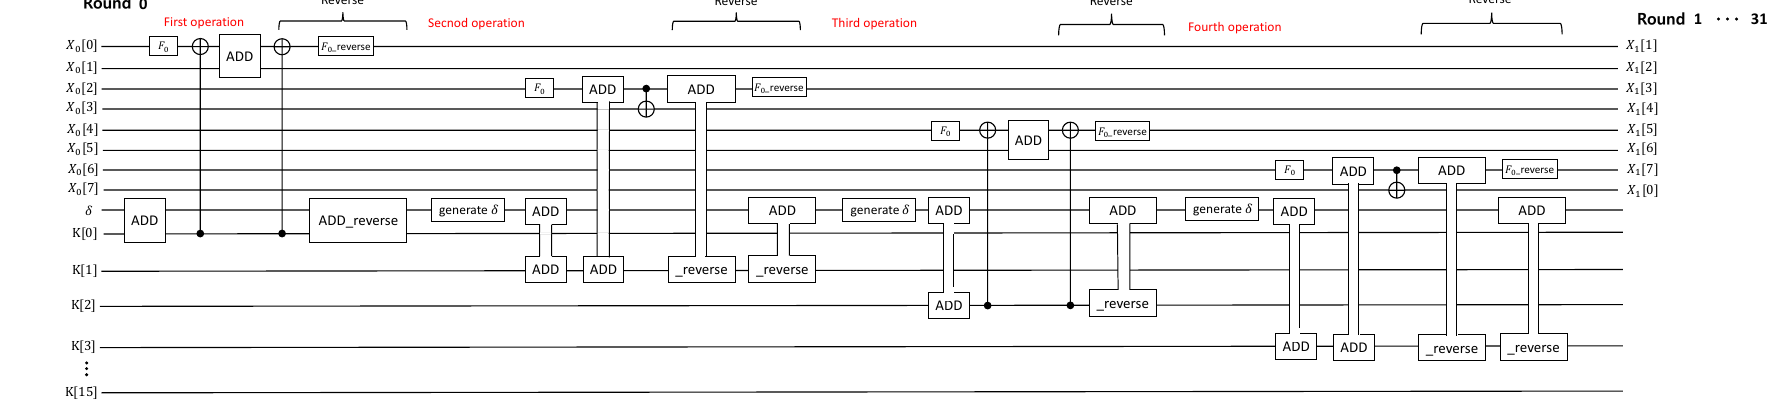
Figure 11. Quantum circuit for